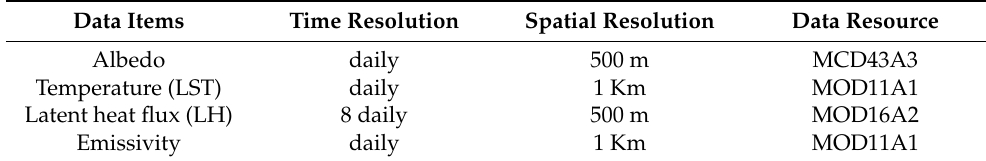
Table 1. Moderate Resolution Imaging Spectroradiometer (MODIS) data items and